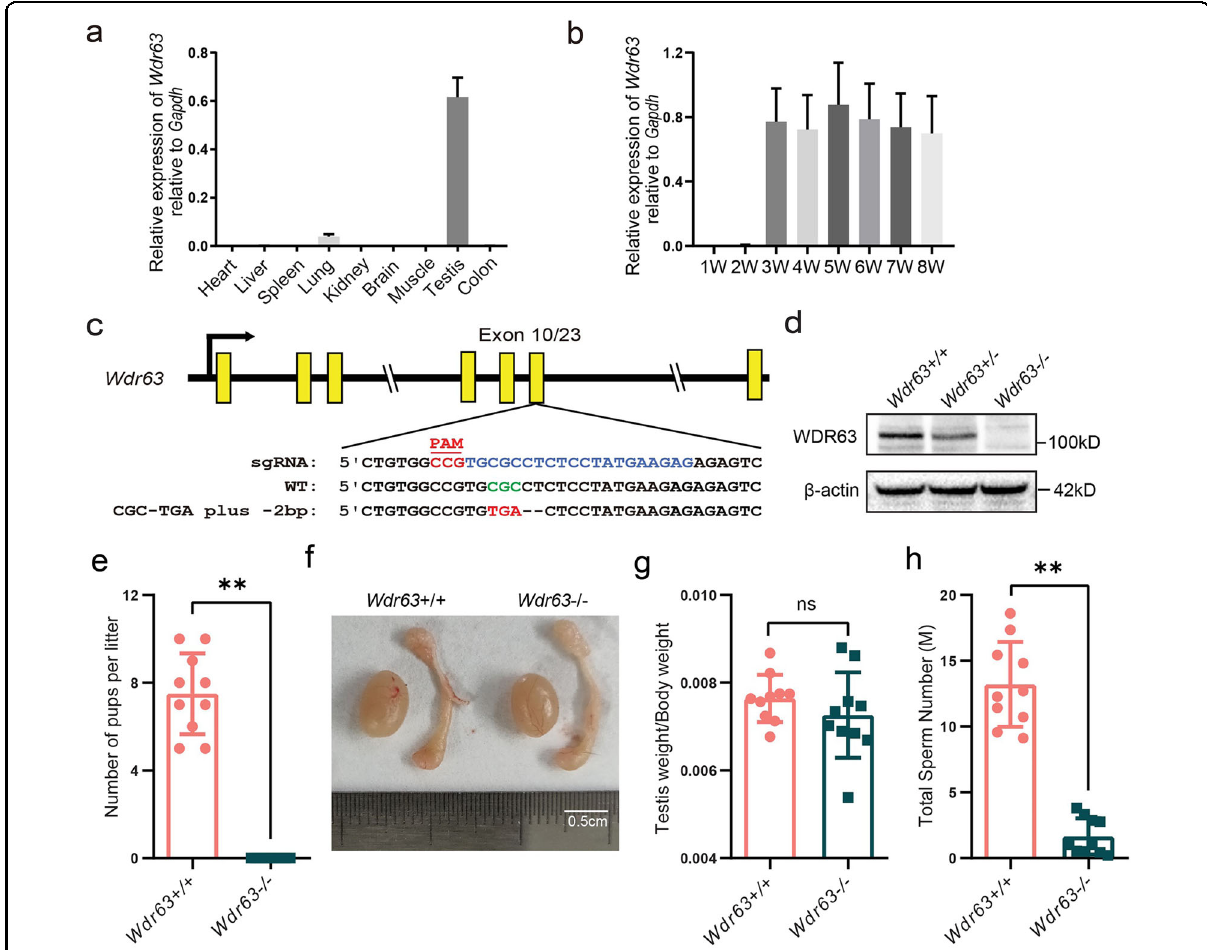
Fig. 2 WDR63 protein is highly expressed in late stages of spermatogenesis and Wdr63 -null males are infertile. a Real-time q-PCR for Wdr63 transcripts in various 8-weeks mouse tissues, and Gapdh gene is used as a control. Error bars, SEM ( n = 3). b mRNA levels of Wdr63 in mouse testis at the indicated time points. Error bars, SEM ( n = 3). c Schematic diagram of CRISPR/Cas9 strategy for the generation of Wdr63 KO mice. The sgRNA was designed to target exon 10 of the Wdr63 , a nonsense mutation (GCG-TGA) plus a 2-bp deletion was obtained. d Western blot analysis of WDR63 protein in wild-type ( Wdr63 + / + ), heterozygous ( Wdr63 + / − ) and homozygous ( Wdr63 − / − ) mice with a mouse polyclonal antibody raised against WDR63. β -actin was used as a loading control. e Fertility analysis for adult Wdr63 + / + and Wdr63 − / − . f , g The morphology and testis weight of testes and epididymis from Wdr63 + / + and Wdr63 − / − males at 8-week-old. Scale bars, 0.5cm. h Total sperm number was dramatically decreased in Wdr63 − / − males compared to that of Wdr63 + / + males. Abbreviations: W, week; M, million. For e to h , n = 10 and the bars represent means± SEM. The statistical analysis was carried out using One-way ANOVA test, ** denotes P < 0.01; ns, not signi fi